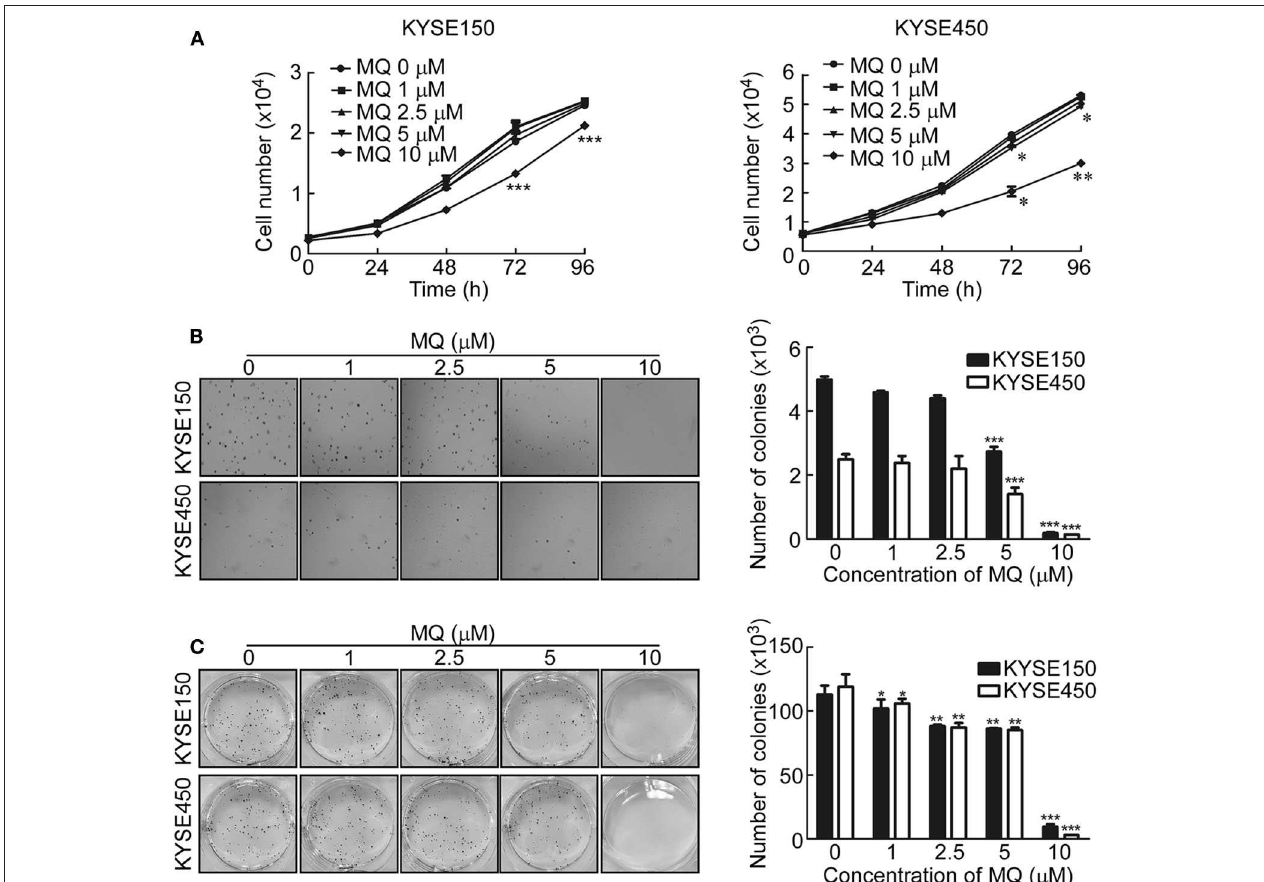
FIGURE 1 | Mefloquine inhibits proliferation and anchorage- independent cell growth of KYSE150 and KYSE450 cells. (A) Cell count after treatment with varying doses of MQ (0, 1, 2.5, 5, 10 µ M) in KYSE150 and KYSE450 cells after 0, 24, 48, 72 and 96h. * p < 0.05, ** p < 0.01, *** p < 0.001 (ANOVA); (B) Soft agar assay of KYSE150 and KYSE450 cells treated with different concentrations of MQ (0, 1, 2.5, 5 and 10 µ M) for ∼ 7 days. ** p < 0.01, *** p < 0.001 (ANOVA); (C) Clone formation assay of KYSE150 and KYSE450 cells treated with different concentrations of MQ (0, 1, 2.5, 5 and 10 µ M), stained with purple crystal after ∼ 7 days. All data are shown as means ± S.D. The asterisks (*, **, ***) indicate a significant decrease ( p < 0.05, p < 0.01, p < 0.001,